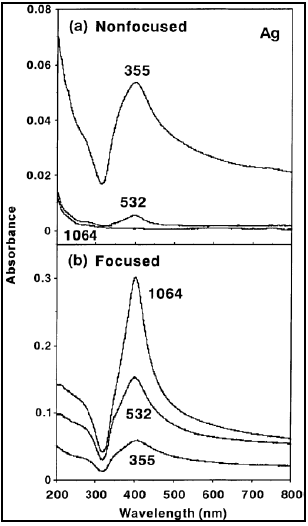
Figure 9. Absorption spectra of Ag colloidal solution prepared with various wavelength laser lights.